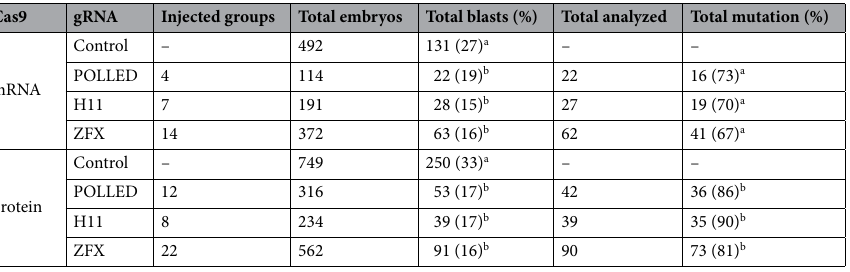
Table 1. Number of zygotes reaching the blastocyst developmental stage following microinjection of either Cas9 mRNA or protein and gRNAs targeting three loci (POLLED, H11, and ZFX) on different chromosomes. In vitro fertilized bovine embryos were injected 18 h post insemination, and the percentage of blastocysts with Cas9-induced mutations was determined by sequence analysis. Letters that differ in the same column are significantly different ( P <